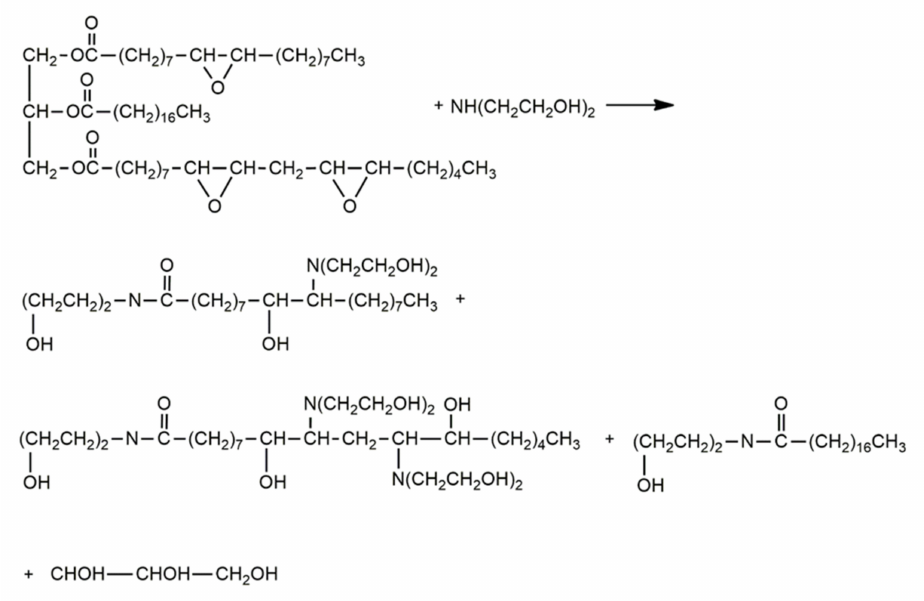
Figure 1. Reactions of oxirane rings and epoxidized glyceride groups in vegetable oils with